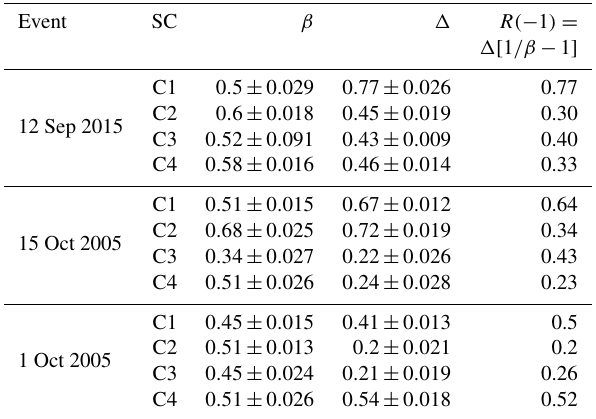
Figure 9. Dependence of the order of the structure function for dif- ferent timescales during dipolarization (event 15 October 2005). Table 4. ESS-analysis parameters and diffusion